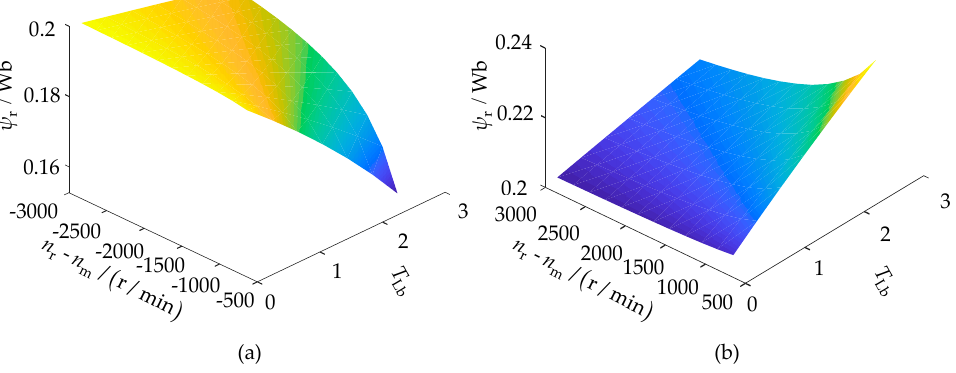
Figure 7. The reference value of rotor flux. ( a ) The reference value of rotor flux when the speed difference is negative. ( b ) The reference value of rotor flux when the speed difference is positive.